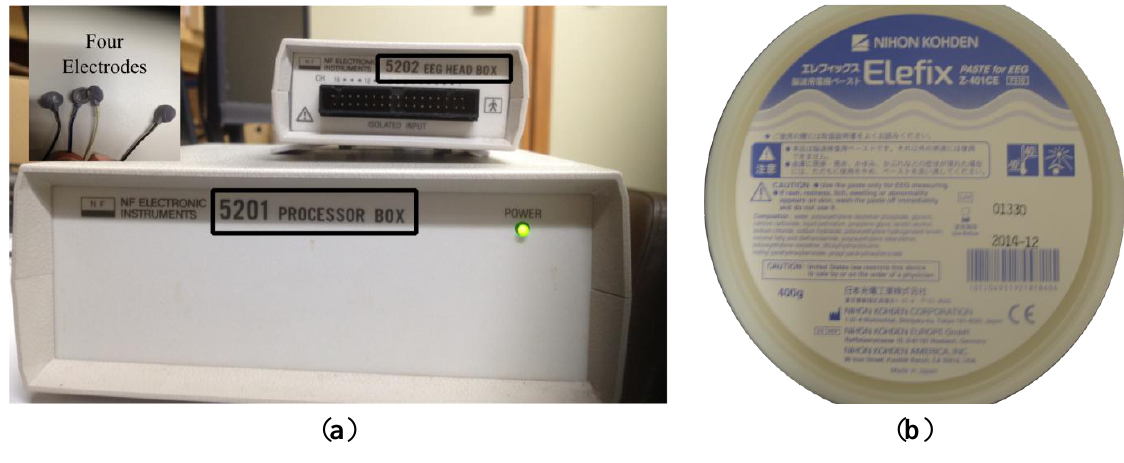
Figure 1. ( a ) NF instrument for EOG sensors with a processor box, a head box and four electrodes. ( b ) Elefix paste produced by Nihon